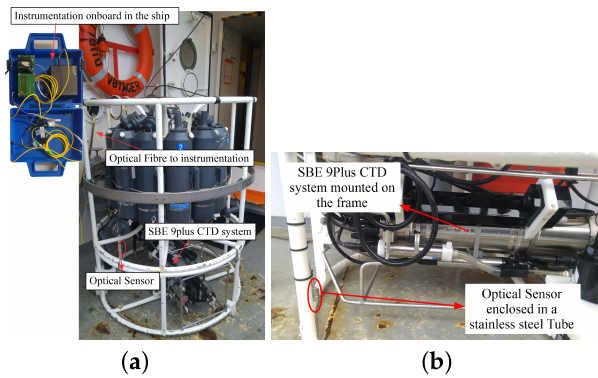
Figure 3. ( a ) Optical sensor mounted on the Conductivity, Temperature and Depth (CTD) rosette; ( b ) Sensor location with respect to the reference sensor.